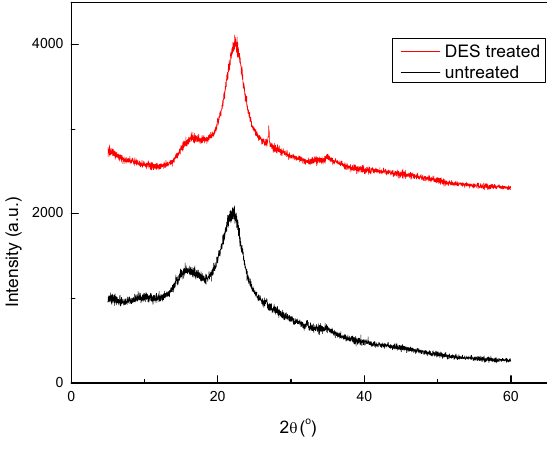
Fig. 9 XRD spectra of the corn stover before and after